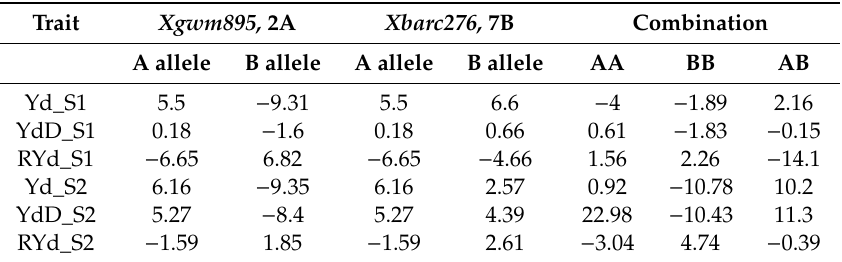
Table 3. Percentage increase or decrease in yield under various conditions with respect to Xgwm895 at 2A and Xbarc276 at 7B. Trait Xgwm895, 2A Xbarc276,